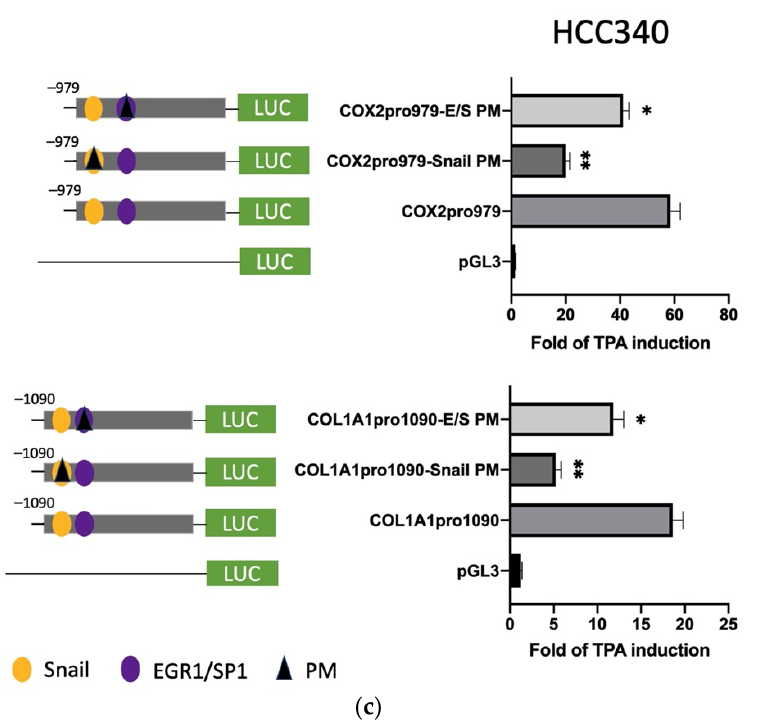
Figure 4. Site-directed mutagenesis for identifying TPA-responsive element on FN, LEF, COX2, and COL1A1 promoter. HepG2 ( a ) and HCC340 ( b , c ) were transfected with pGL3, the wild type FNpro1150, LEFpro1595 ( a , b ), COX2pro921, and COL1A1pro1090 ( c ) or site-directed mutated types of each promoter with altered SNA binding sites or EGR1/SP1 region, as indicated (PM 1, 2 or 3: point mutation 1, 2 or 3), followed by TPA treatment for 12 h. Dual-luciferase was performed. Relative fold of TPA-induced luciferase activity was calculated, taking the data of pGL3 group as 1.0. In each figure, (*, **) represent the statistically significant difference ( p < 0.05, p < 0.001, N = 3) between the indicated mutant promoter group and the wild-type promoter.